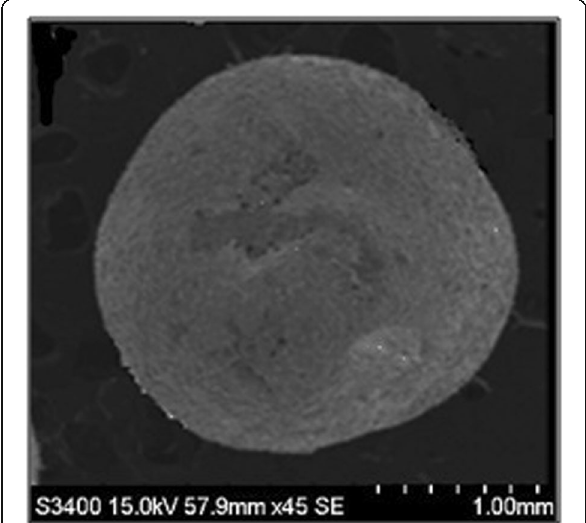
Fig. 4 Scanning electron microscopy (SEM) image of